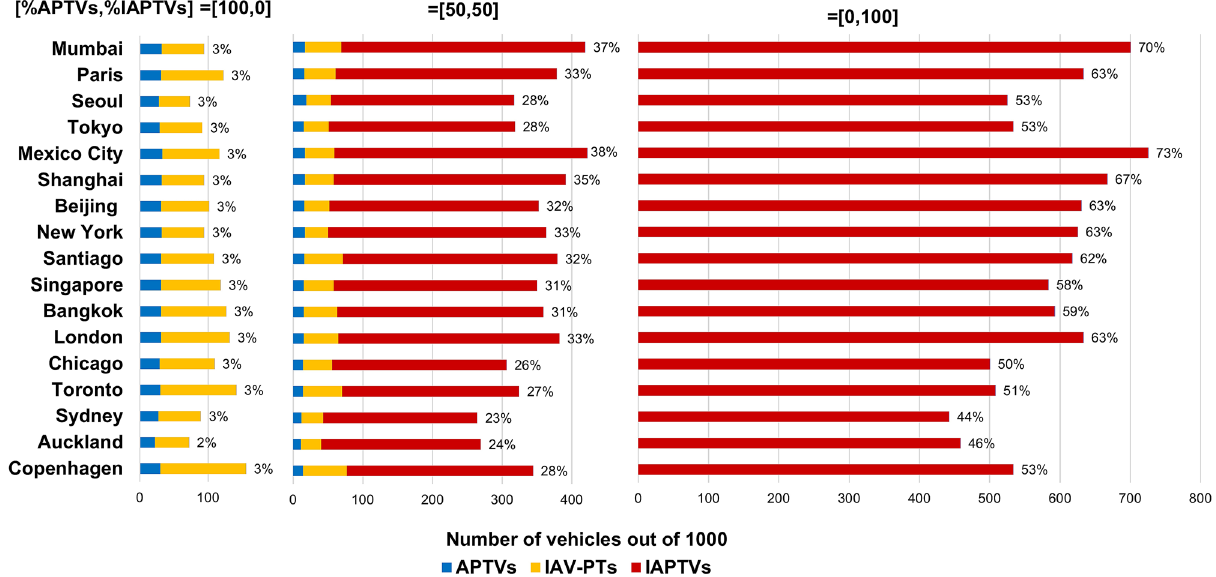
Figure 5. Reduction expected in the number of vehicles based on a future scenario (Fig. 4 and Supplementary Table 6) . There are three types of automated vehicles represented: IAPTV, local service IAV-PT, and a shared APTV for three cases: [%APTVs, %IATPVs] = [100, 0], [50, 50] and [0, 100]. The percent at the end of each bar shows the percentage of vehicles on the main road between A and B out of the 1000 ordinary PCs, i.e., without